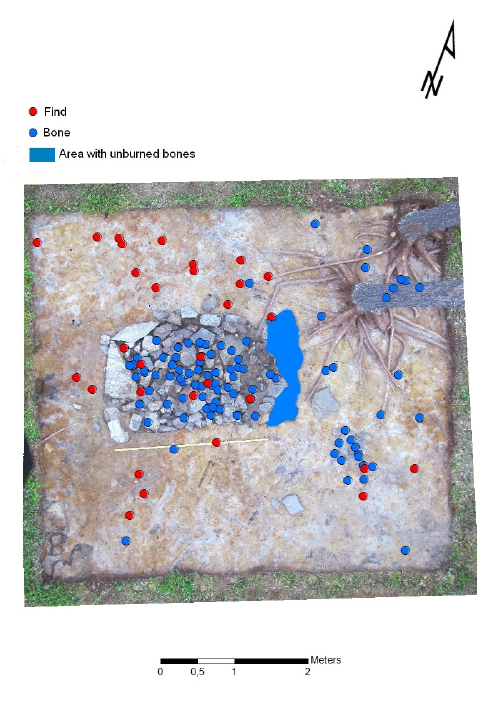
Figure 7. Distribution of artefacts and bones in the H3 area, Steintjørna.